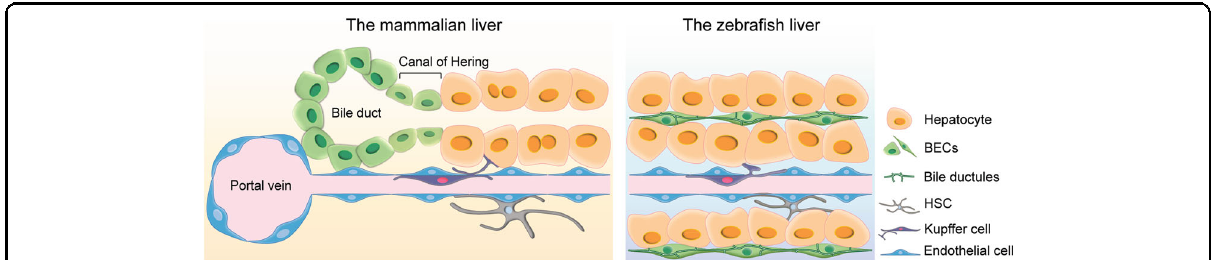
Fig. 1 The structure of the liver in mammals and zebra fi sh. The liver consists of hepatocytes, BECs, Kupffer cells, HSCs, and endothelial cells. LPCs are thought to arise near bile ductules, also known as the canals of Hering, which are positioned between the bile duct and hepatocytes. In the zebra fi sh liver, most BECs make up bile